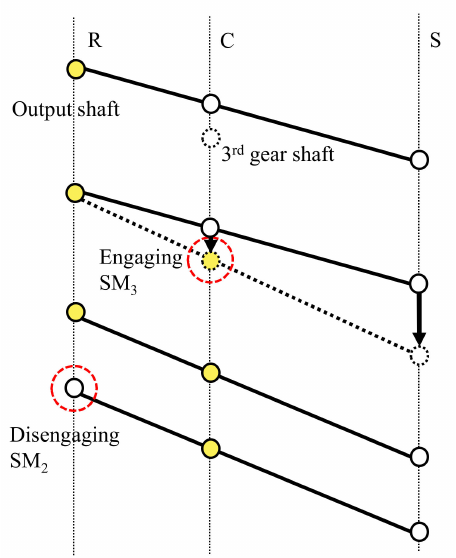
Figure 6. Lever analogy for describing shifting from even gear-stage to odd gear-stage (R: Ring gear, Engine, C: Carrier gear, S: Sun gear, Electric